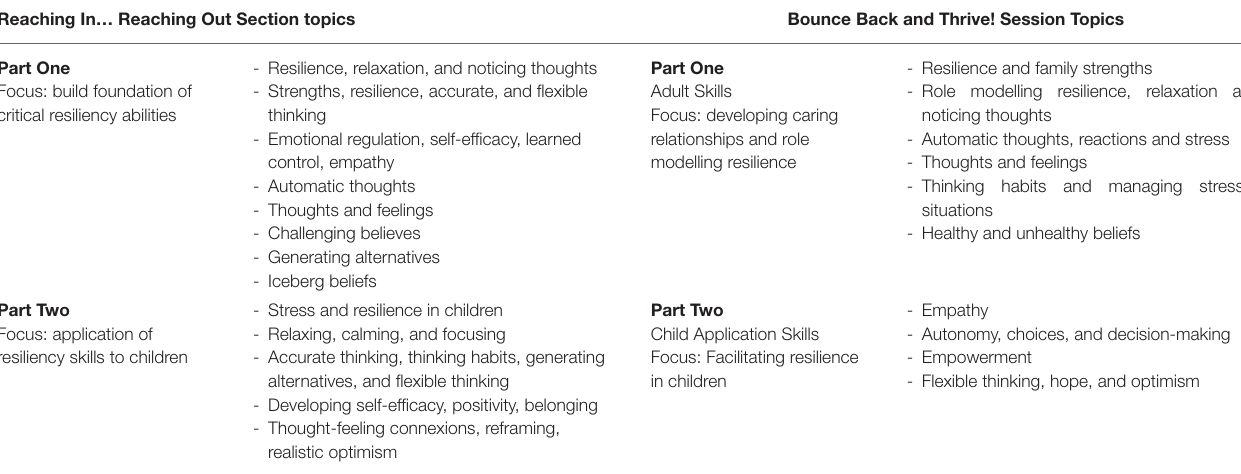
TABLE 3 | Reaching In… Reaching Out and Bounce Back and Thrive! Sessions and